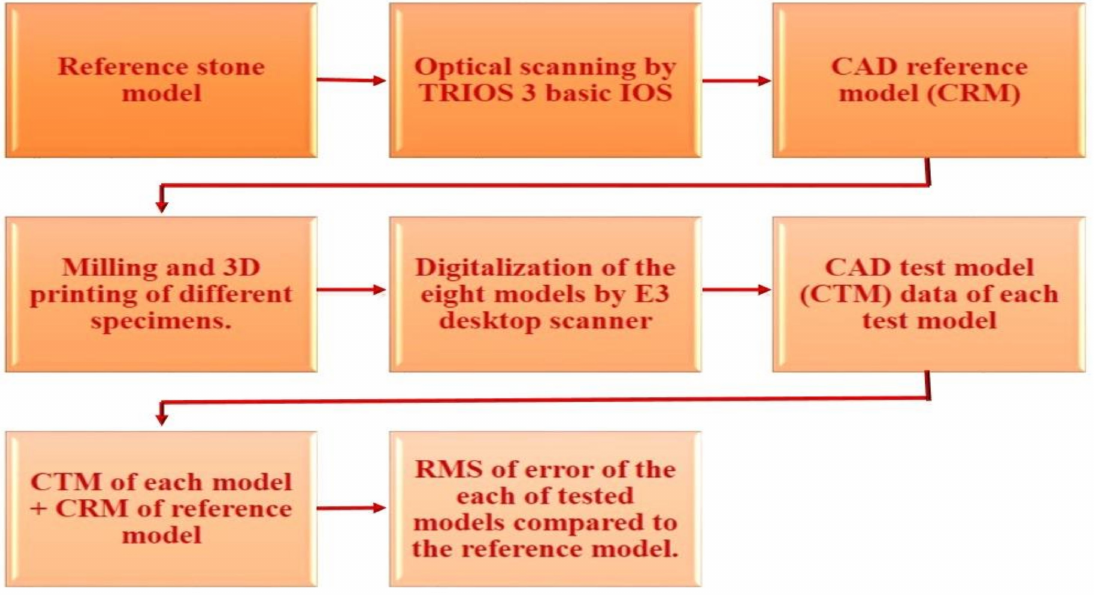
Figure 8. The process of 3D accuracy measurement by superimposition.